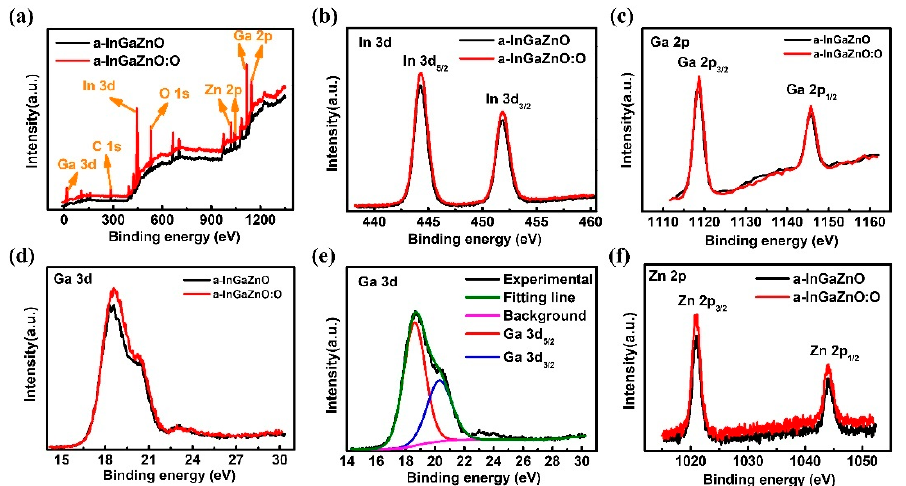
Figure 6. XPS spectra of different elements in a-InGaZnO based film: ( a ) full spectrum; ( b ) In 3d; ( c ) Ga 2p; ( d ) Ga 3d; ( e ) analytical images of Ga 3d peaks; ( f ) Zn 2p. ( c ) Ga 2p; ( d ) Ga 3d; ( e ) analytical images of Ga 3d peaks; ( f ) Zn